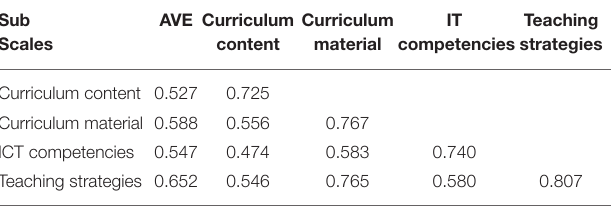
TABLE 3 | Convergent and discriminant validity.